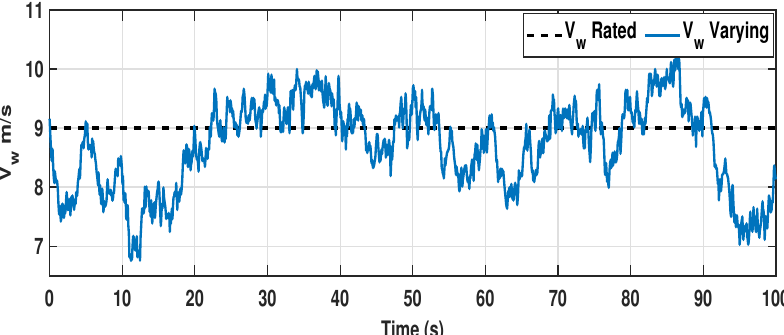
Figure 6. Random wind profile with mean value of 9 m/s for region II and III operation.